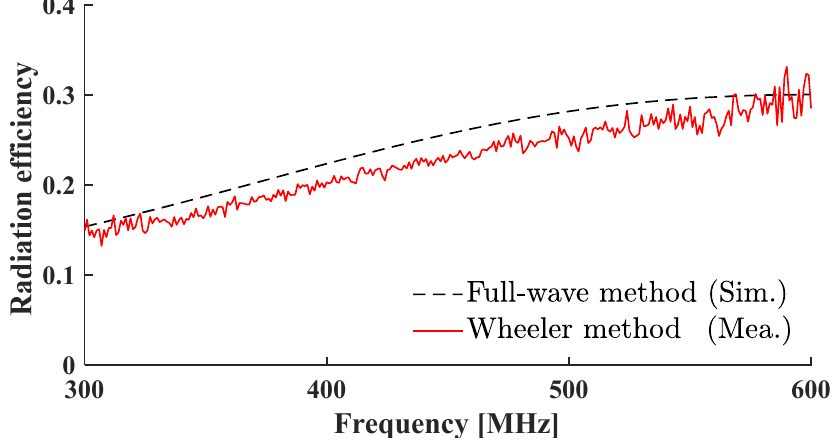
Figure 10. The measured and simulated radiation efficiency ( 𝑑 (cid:3045) = 𝑟 (cid:3050) = 20 mm).